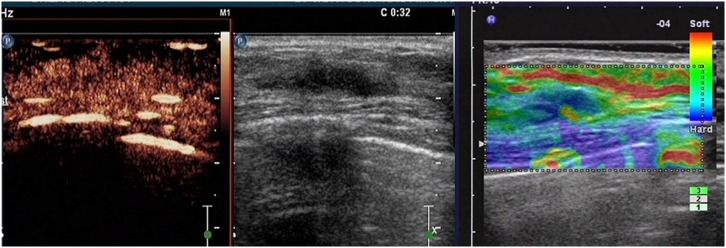
A lesion was categorized as BIRADS 4B, with a score of 4 by elastography, and with a score of 2 by CEUS 5-point scoring system.The pathological result of the lesion was ductal carcinoma in situ.